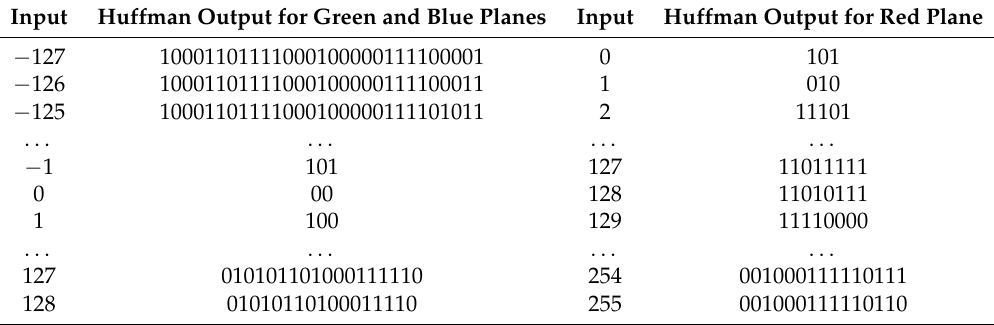
Table 2. Table showing a few components of the Huffman tree for Green and Blue